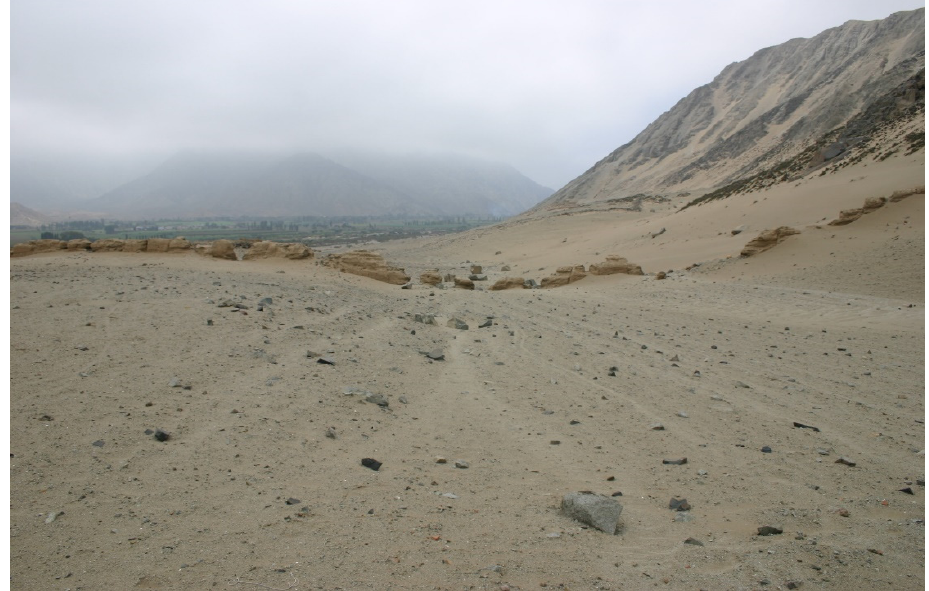
Figure 29. Further stone wall aeolian sand barrier closest to Caral city limits. CFD-generated Figures 24 and 26 detail the effects of a later flood event that superim- posed sediment deposits upon a previously established subsea ridge with results specific to shallow seabed angles. Shown in Figure 25 are the fluid fraction results: f = 1.0 represents ocean water, f = 0.0 represents the sediment slurry stream and intermediate f values indicate slurry–ocean water mixture states. Sediment deposits on top of, and on each side of, the original subsea ridge provide the barrier mechanism for accretion of inland sand and flood deposits. A trace ridge accumulates seaward of the main sediment ridge and affects subsequent ridge development as the sea bottom geometry has been altered together with the river discharge outlet geometry. This result, when repeated for multiple flood